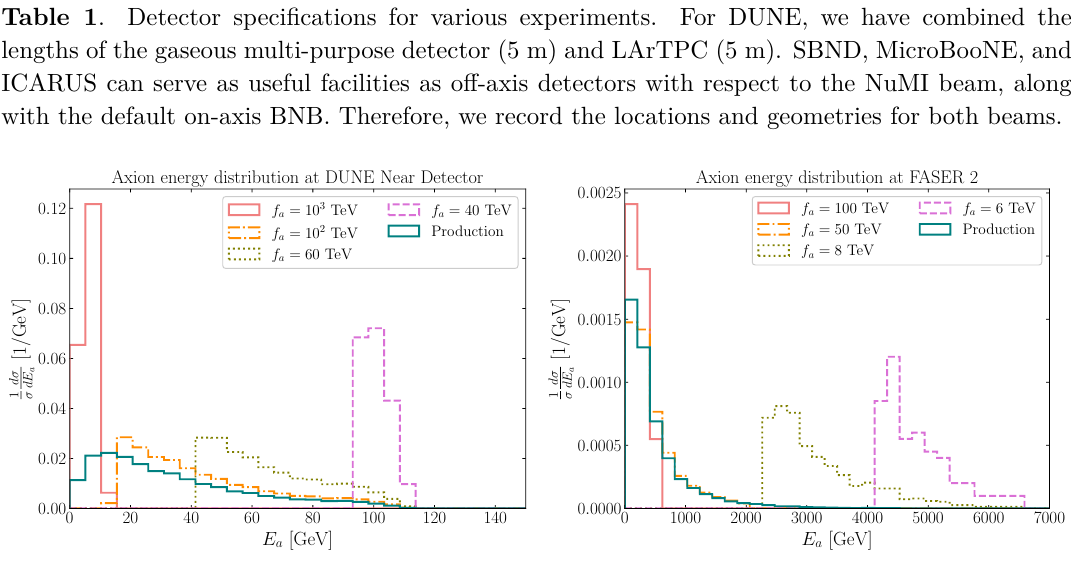
Figure 3 . The differential energy distribution of the axions at production (in teal) and at the detectors (for various values of f a in other colors and line styles). We fix c ‘ = 1 / 36 and m a = 0 . 8